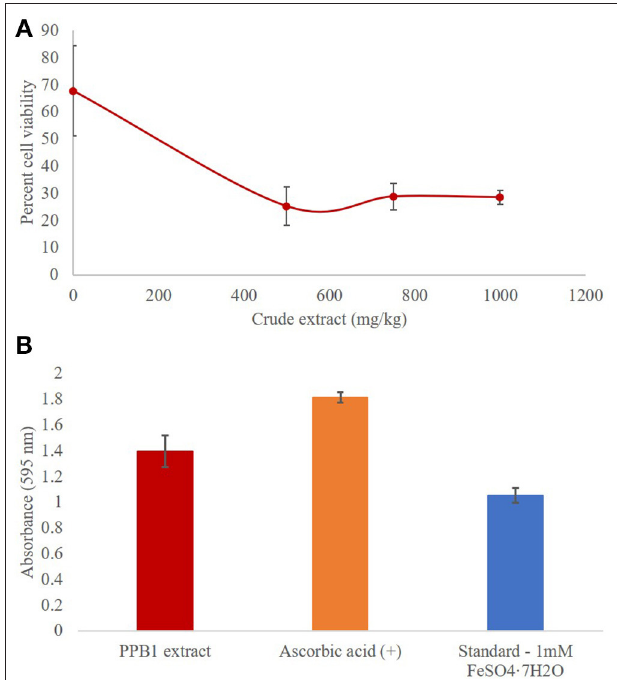
FIGURE 4 | (A) Antimicrobial activity of PPB1 crude extract against S. aureus . PPB1 crude extract demonstrated a significant decrease in cell viability at 500 mg/kg (25.2 ± 2.6), 750 mg/kg (28.8 ± 4.8), and 1,000 mg/kg (28.5 ± 7.1). Error bars represent the standard deviation of the samples. (B) Antioxidant activity of PPB1 crude extract via FRAP assay. The PPB1 crude extract demonstrated significant ferric-reducing potential (1.395 ± 0.123; p ≤ 0.05) in comparison to the EtOH negative control (0.004 ± 0.001). Error bars represent the standard deviation of the samples.